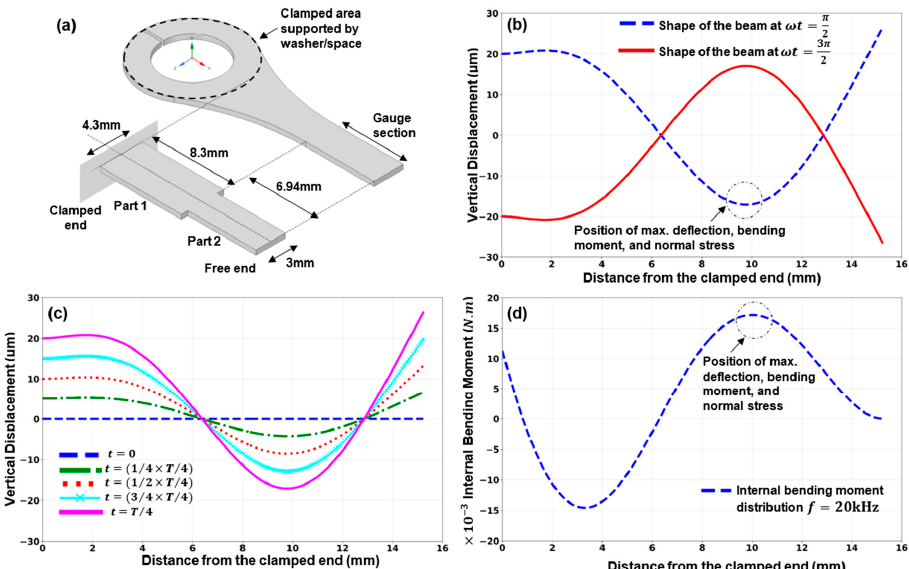
and 3 π . ( c ) The 2 2 𝑎𝑛𝑑 (cid:2871)(cid:3095) . ( c ) The beam’s (cid:2870) (cid:2870)